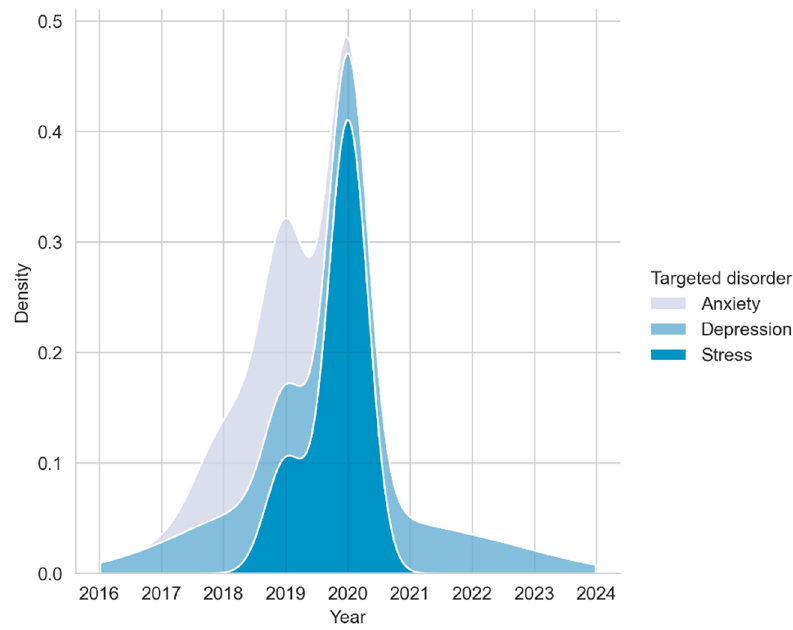
Figure 2. Kernel density estimation (KDE) of targeted disorder by date